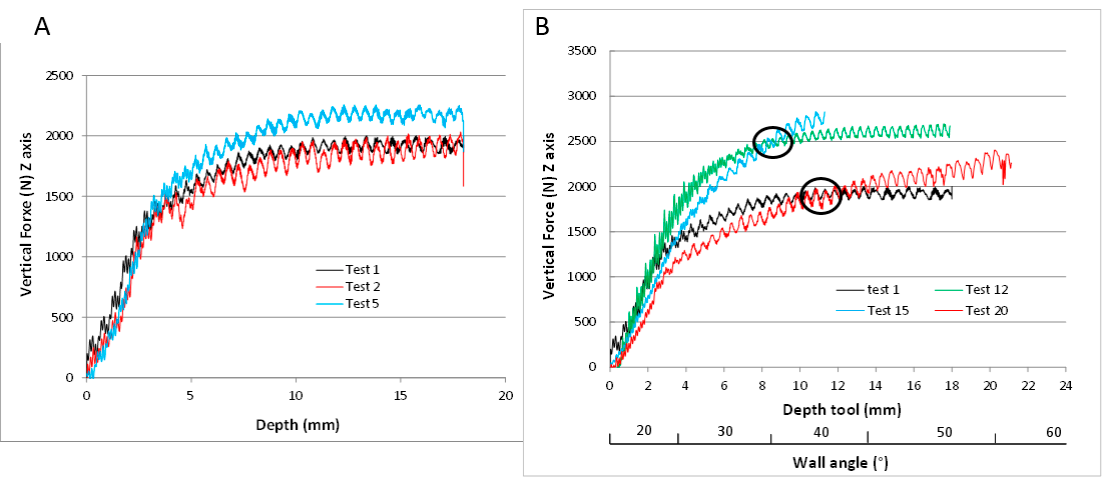
Figure 9. ( A ) Tool forces on the Z-axis for different SPIF assays on constant wall angle cones. ( B ) Comparison of forces for truncated cones with variable and constant slopes.